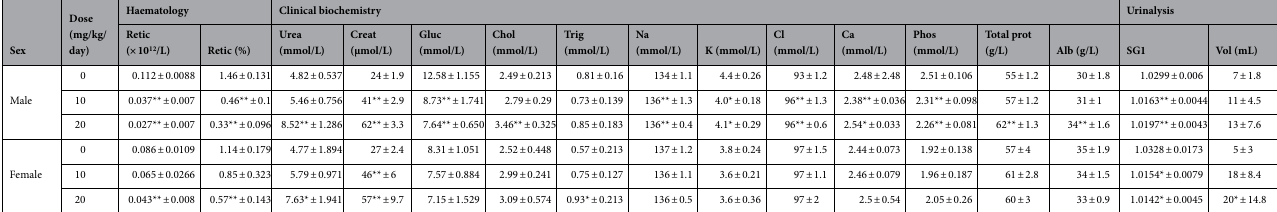
Table 1. Group mean values of significant changes obtained in haematology, clinical biochemistry and urinalysis tests (group mean values ± standard deviation) in male and female rats treated intravenously once daily for seven days with 0 (vehicle = 0.9% saline solution), 10 and 20 mg/kg/day of SET-M33 peptide. Retic reticulocyte count (absolute and relative), Creat creatinine, Gluc glucose, Chol total cholesterol, Trig triglycerides, Na sodium, K potassium, Cl chloride, Ca calcium, Phos inorganic phosphorus, Total Prot total protein, Alb albumin, SG1 specific gravity, Vol volume. Significant differences between peptide vs. control groups are expressed at 5% (* p < 0.05) or 1% (** p < 0.01) level. For statistical analysis, Dunnett, Shirley or Williams tests were